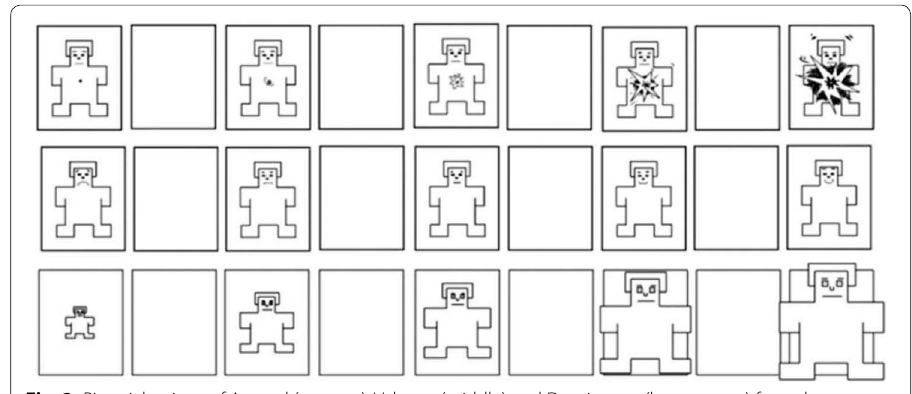
Fig. 2 Pictorial ratings of Arousal (top row), Valence (middle) and Dominance (bottom row) from the self‑assessment manikin scales (Bradley and Lang